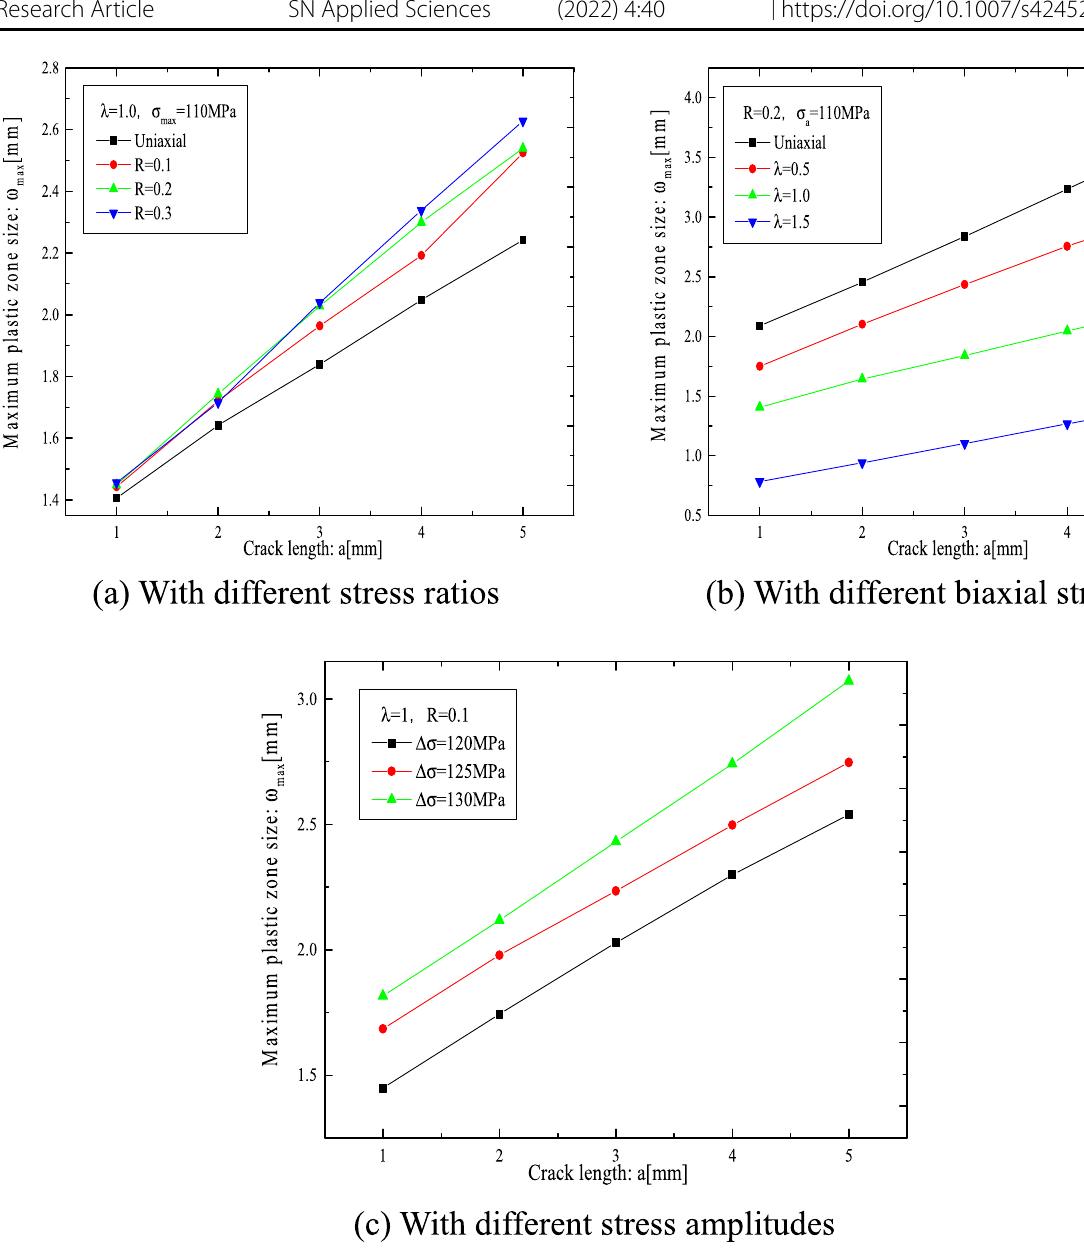
Fig. 21 Plastic zone radius sizes of the inclined-crack specimen for different biaxial